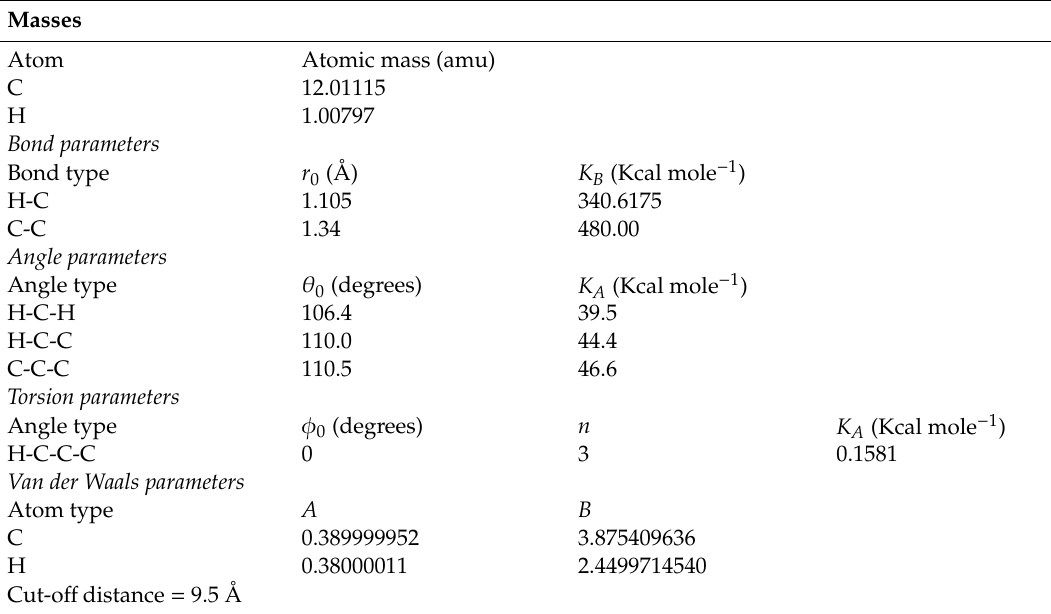
Table 1. Consistent valence force field (CVFF) parameters for